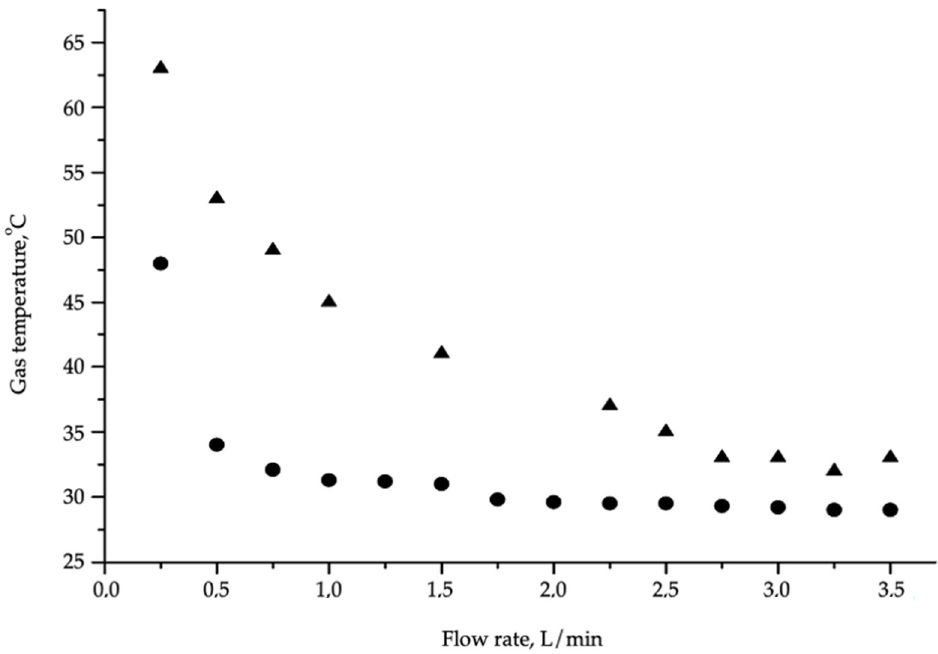
Figure 3. Dependence of plasma jet gas temperature on flow rate at short pulse ( ○ ) and sine ( ∆ ) excitation voltage.